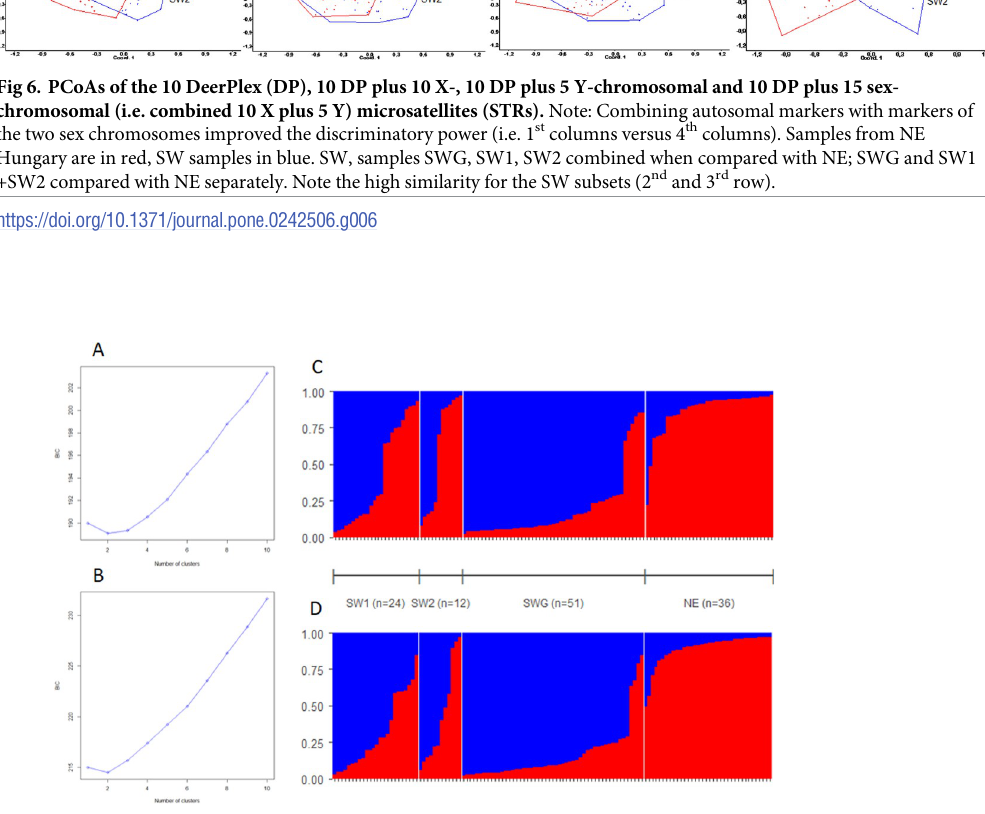
Fig 7. PCoAs of the 10 DeerPlex (DP), 10 DP plus 10 X-, 10 DP plus 5 Y-chromosomal and 10 DP plus 15 sex- chromosomal (i.e. combined 10 X plus 5 Y) microsatellites (STRs). (A) and (B): Bayesian information criterion (BIC) according to the number of clusters using 10 autosomal (DP) STRs and 10 autosomal (DP) plus 15 sex chromosomal STRs, respectively. Note that the most likely number of clusters is two (i.e. BIC is the lowest at K = 2). (C) and (D): Bar plot of membership probabilities at K = 2 using 10 DP STRs and 10 DP plus 15 sex chromosomal STRs, respectively. Each vertical bar represents an individual red deer with the share of probabilities assigned to the two genetic clusters (in blue and red). Samples are grouped according to sampling sites (see in brackets below the line between C and D) and aligned according membership probabilities. Membership probabilities are in blue for cluster I (“Gemenc type”), and in red for cluster II (“Zemple´n type”). Note: C, average membership probabilities belonging to the cluster I in the case of 10 DP STRs are 0.585, 0.414, 0.806 and 0.135 for SW1, SW2, SWG and NE, respectively; D, in case of 10 DP plus 15 sex chromosomal STRs are 0.704, 0.646, 0.839 and 0.108 for SW1, SW2, SWG and NE, respectively.